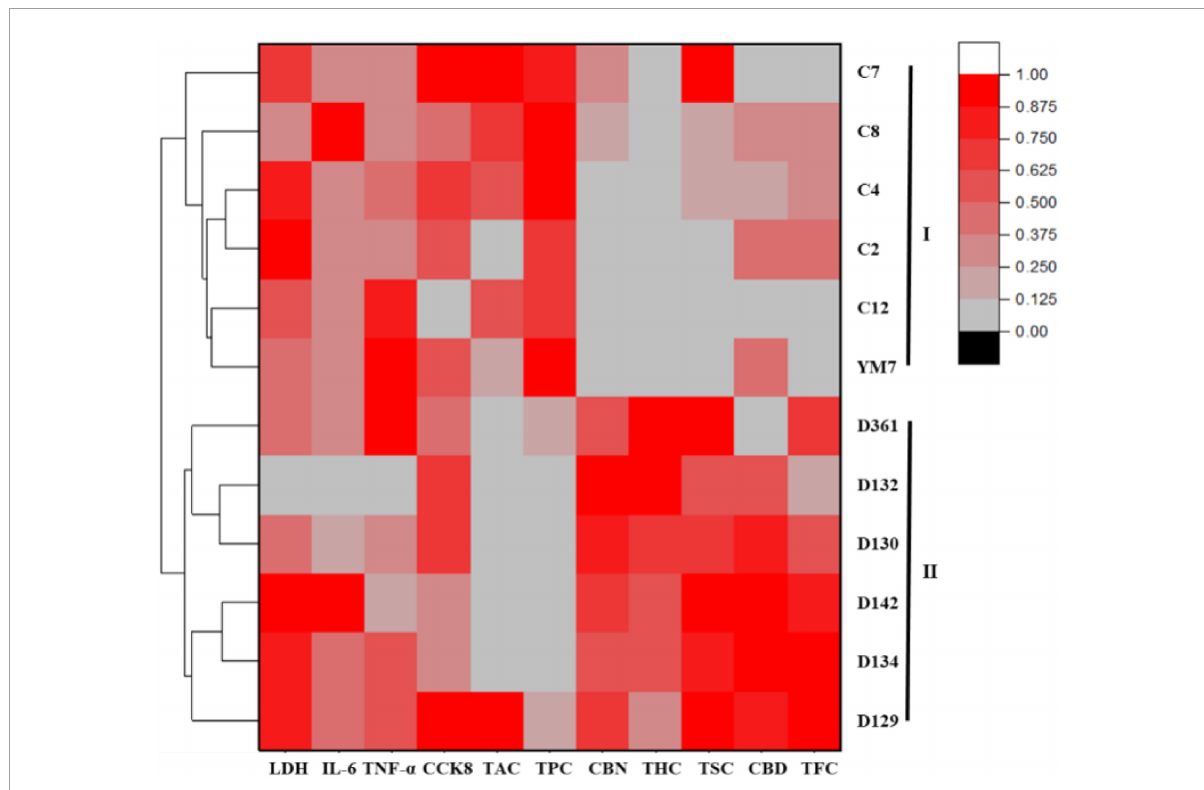
FIGURE6 Hierarchical clustering heat map of the 12 hemp leaves, with the degree of differences marked with red and